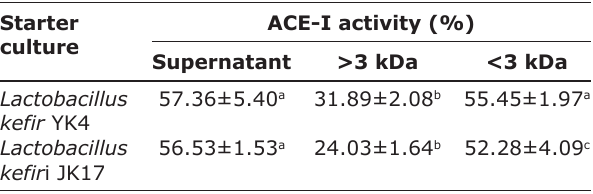
Table-4: ACE-I activity of supernatant, fractions of >3 kDa and <3 kDa in milk fermented by Lactobacillus kefiri YK4 and Lactobacillus kefiri